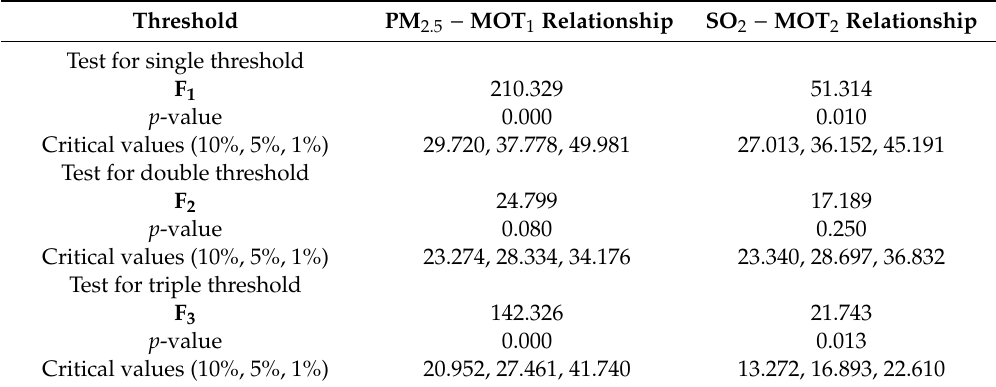
Table 4. Tests for threshold e ff